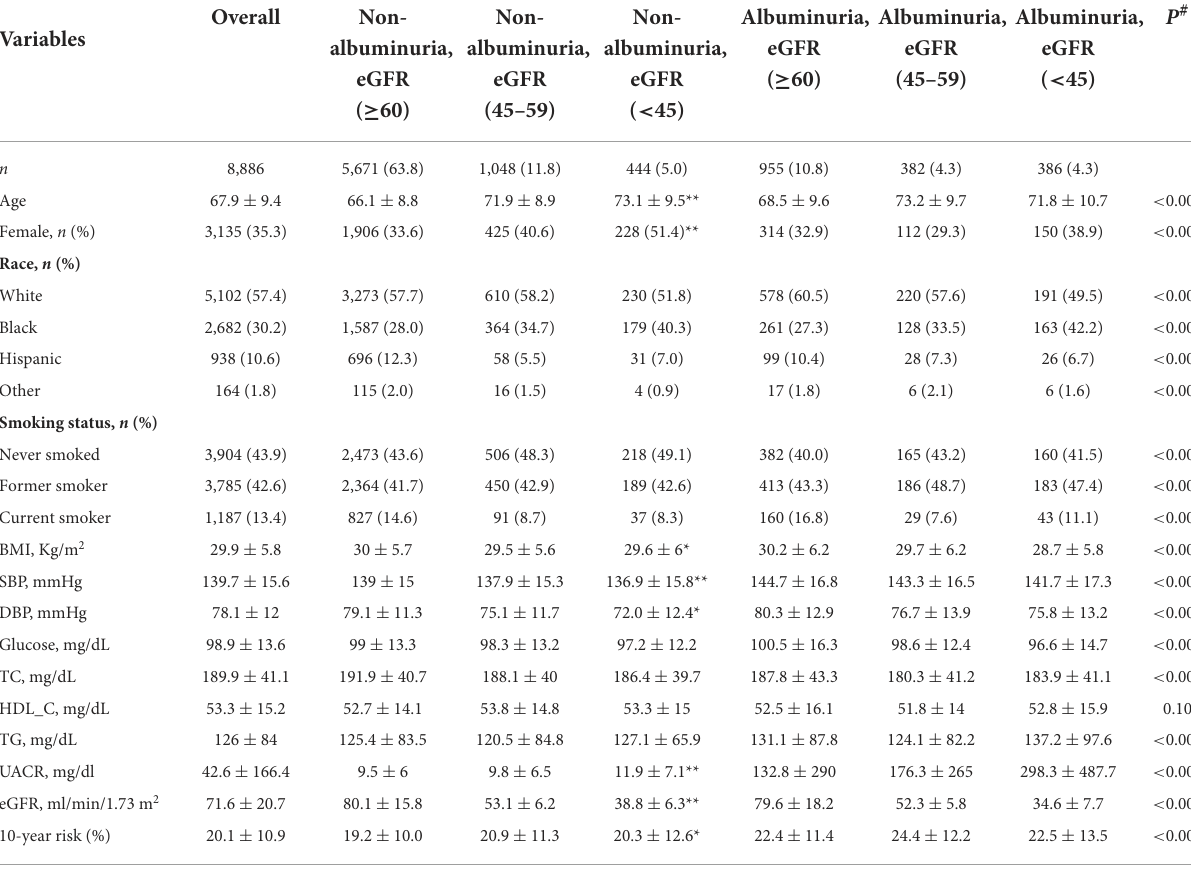
TABLE 1 Baseline characteristics of study participants by baseline CKD and albuminuria